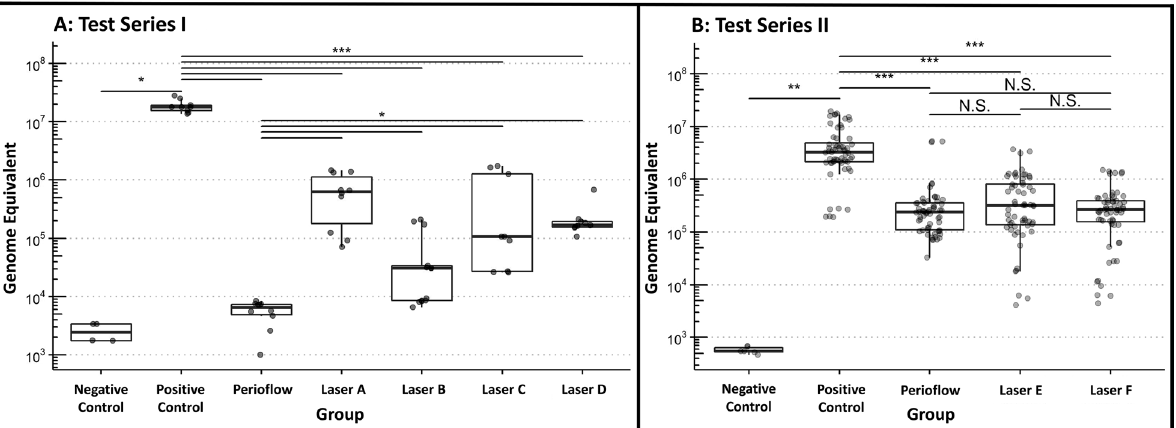
Fig. 5 Genome equivalent values across all groups in the first ( A ) and second ( B ) test series. Dots represent single qPCR measurements (3 per disk)